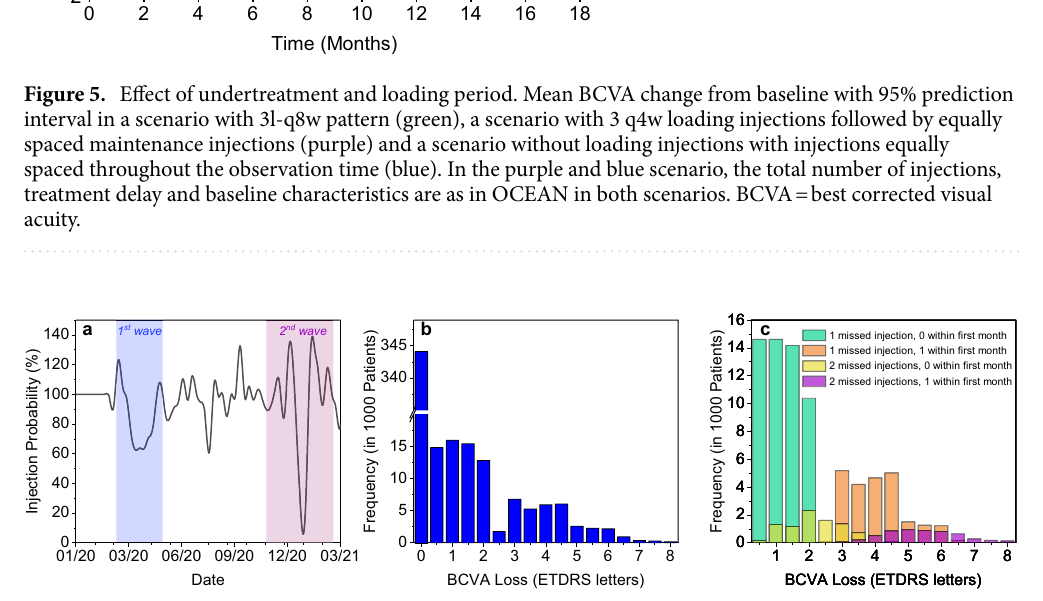
Figure 6. Impact of missed injections due to COVID-19 pandemic. ( a ) Percentage of performed injections based on daily Lucentis distribution numbers in Germany. ( b ) Histogram of BCVA loss due to COVID-19 from all patients, including patients without missed injections. ( c ) Histogram of BCVA loss due to missed injections, stratified according to number of missed injections and if one missed injection was within the first month of treatment. BCVA = best corrected visual